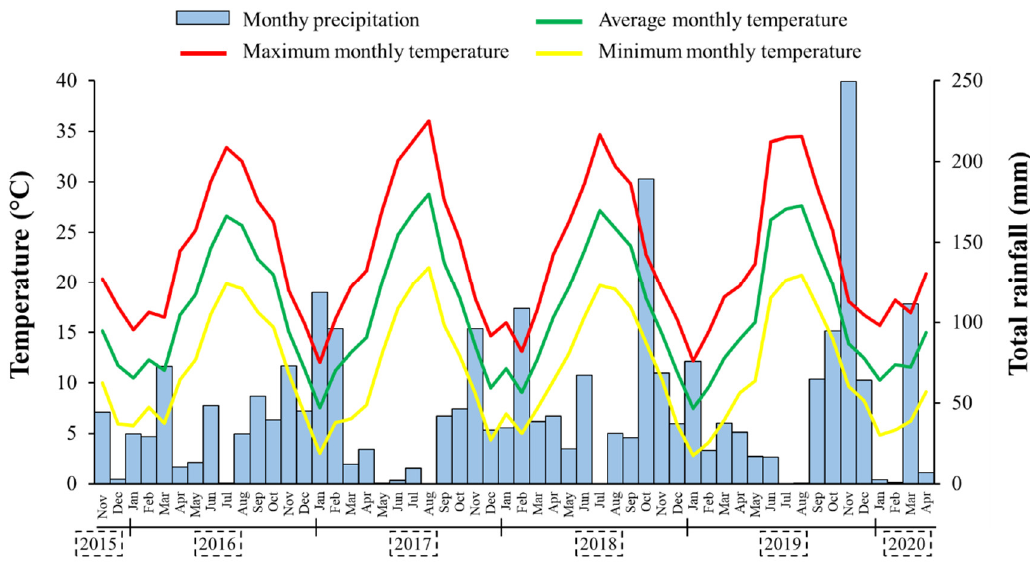
Figure 5. Total rainfall, maximum, average and minimum monthly temperatures distribution during the five cropping